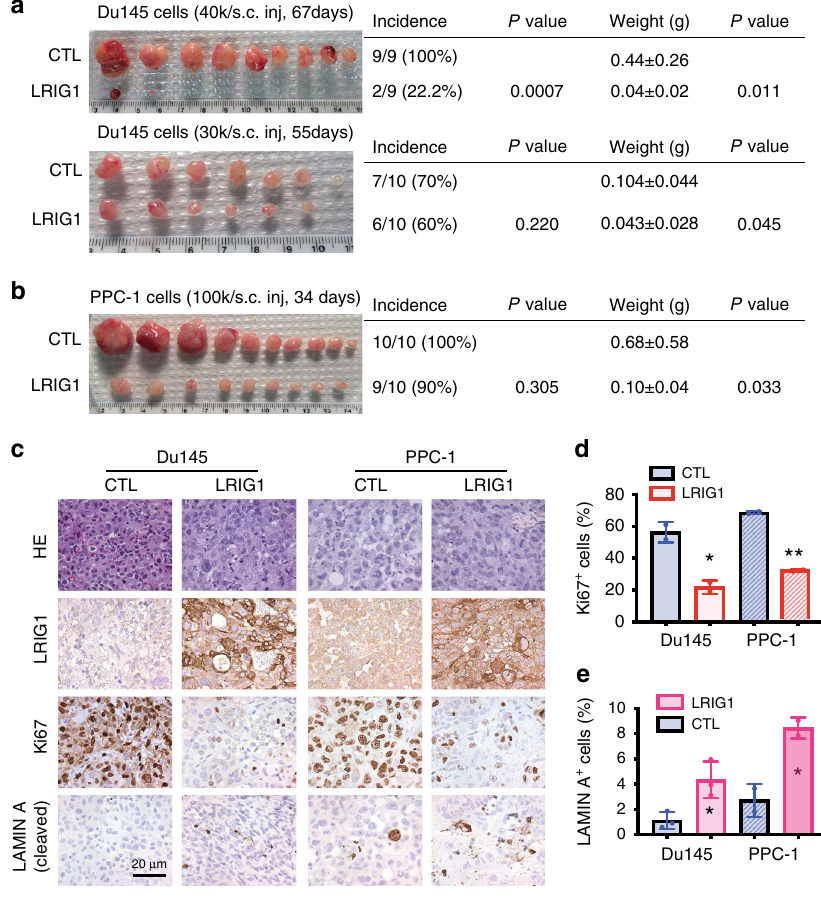
Fig. 2 LRIG1 overexpression inhibits tumor regeneration in AR − /lo PCa xenografts. a , b LRIG1 overexpression inhibits tumor regeneration and growth of AR - Du145 ( a ; two independent experiments shown) and PPC-1 ( b ) cells. PCa cells infected with control (CTL) or LRIG1-expressing lentiviral vectors (MOI 5), and subcutaneously (s.c) injected (cell # indicated) in NOD/SCID mice. Tumors were harvested at the days indicated. Tumor incidence, endpoint tumor weight, and P values are presented on the right. The P -values for tumor incidence and weight were determined using χ 2 test and Student ’ s t -test, respectively. c Representative IHC images of LRIG1 (Sigma mAb, 1:100 dilution), Ki67 (Novus Biological, 1:500 dilution), and cleaved LAMIN A for apoptosis (Cell Signaling, 1:500 dilution) staining in endpoint tumors. In all, 4 μ m serial sections were stained for the molecules indicated. Original magni fi cations were ×400 and a scale bar was indicated on one panel. d , e Quanti fi cation of Ki67 + ( d ) and LAMIN A + ( e ) cells in endpoint tumors. Bars, mean ± SEM (by counting a total of 1000 – 1500 cells from 2 to 3 tumors from each model. * P < 0.05; ** P < 0.01 (two-tailed unpaired Student ’ s t -test). *Source data for Fig. 2a, b, d, e are provided as a Source Data fi